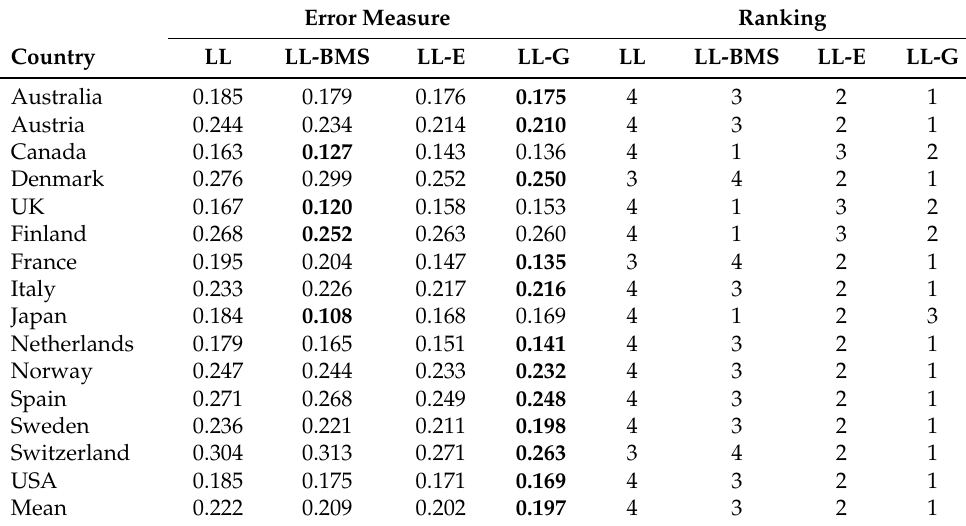
Table 4. Multi-population out-of-sample forecasting performance. Error Measure